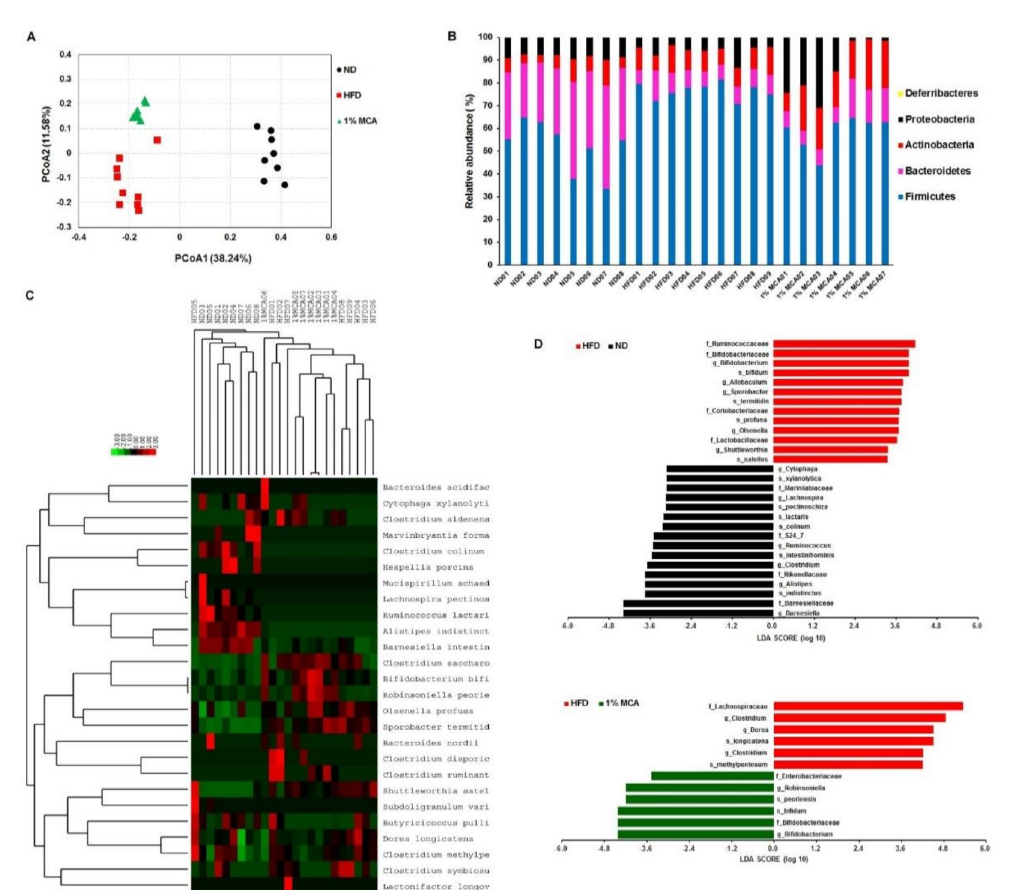
Figure 6. MCA modulated the composition of the HFD-disrupted gut microbiota. ( A ) Principal coordinate analysis (PCoA) of gut microbiota based on operational taxonomic unit (OTU) abundance. ( B ) Bacterial taxonomic profiling at the phylum level of gut microbiota. ( C ) Unweighted UniFrac tree comparing 16S rRNA clone library sequences from the gut microbiotas of different groups (upper panel). The relative abundance of bacterial classes observed in these data sets is represented in heatmaps below each tree (lower panel). ( D ) Linear discrimination analysis (LDA) effect size (LEfSe) was calculated to explore the taxa within the lowest taxonomic level possible that more strongly discriminate between the gut microbiota of ND vs. HFD (upper panel) and 1% MCA vs. HFD (lower